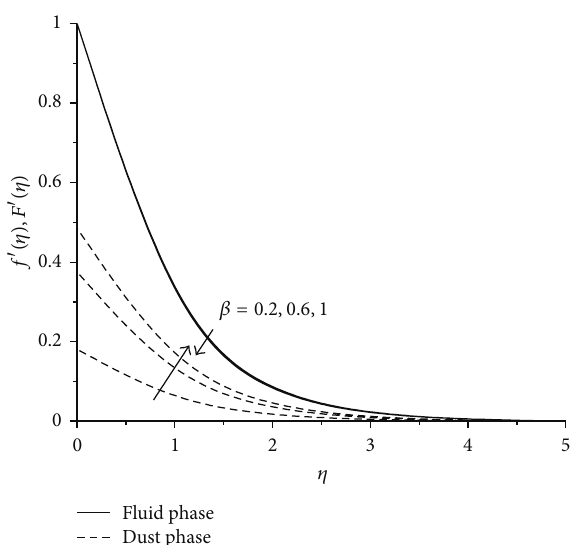
Figure 2: Effect of 𝛽 on velocity profiles with 𝑁 = 𝜆 = Ec = 𝑆 = 0.5 and Pr = 0.72 .